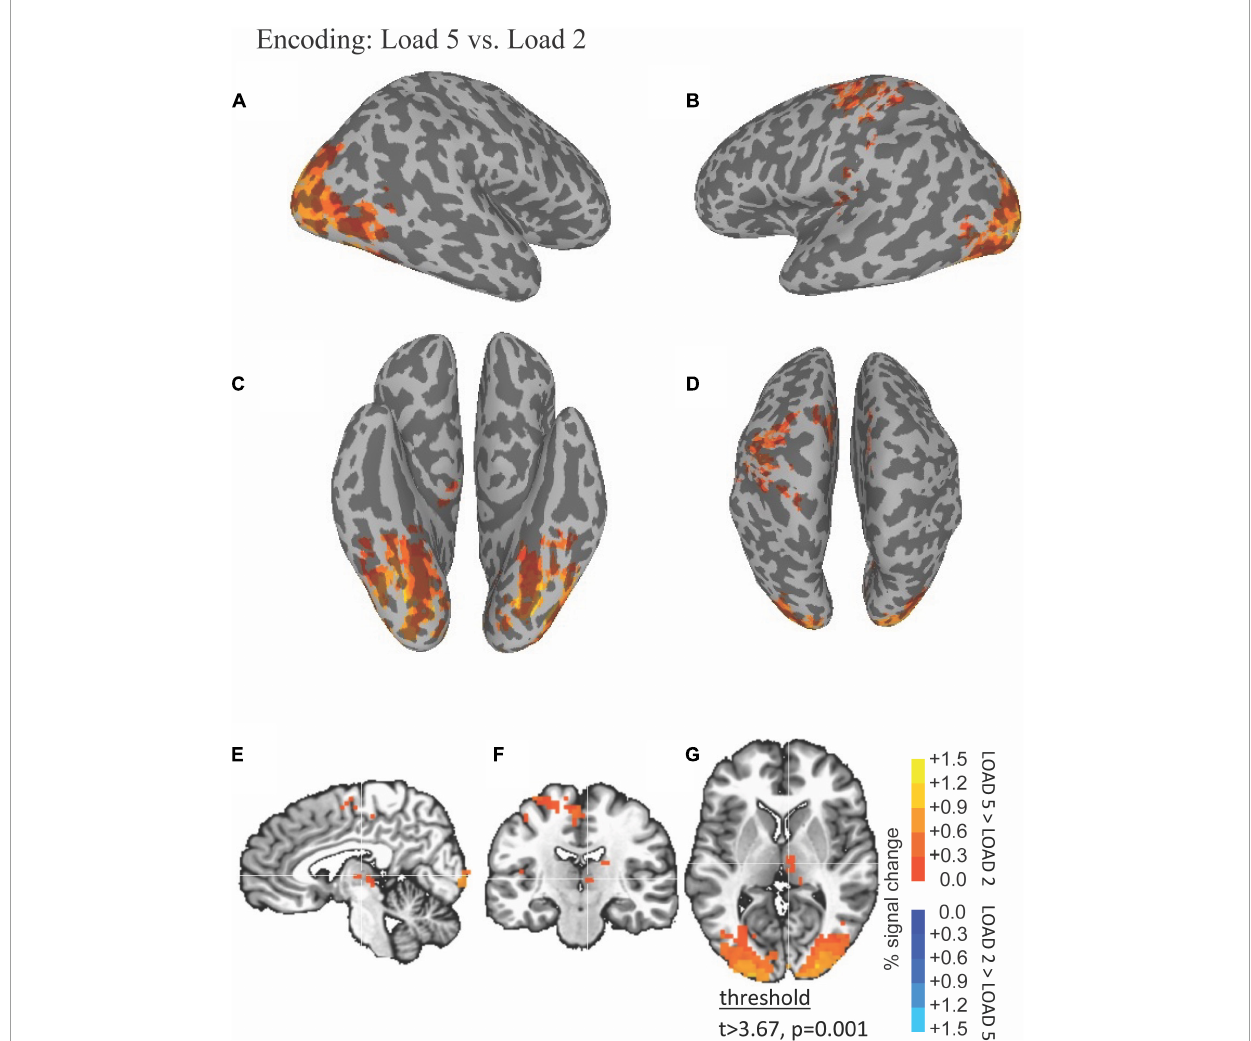
FIGURE2 Functional magnetic resonance imaging (fMRI) Differences Between High and Low Load during the Encoding Period. Thresholded fMRI statistical maps ( t > 3.67, p = 0.001, and cluster size > 40 voxels) displayed on inflated cortical surface representations [ (A) left hemisphere, (B) right hemisphere, (C) ventral view, and (D) dorsal view] and orthogonal views [ (E) sagittal, (F) coronal, and (G) axial view]. The crosshairs in the orthogonal view is located x = 28, y = 38, and z = 48 mm, the peak location of a cluster of activity in medial dorsal nucleus of the thalamus that was greater for high compared to low load